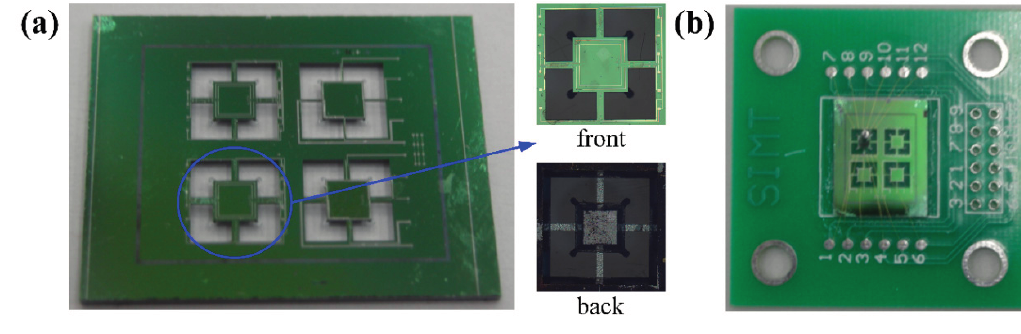
Figure 7. Picture of manufactured sensor. ( a ) Sensing unit; ( b ) Assembled sensor.